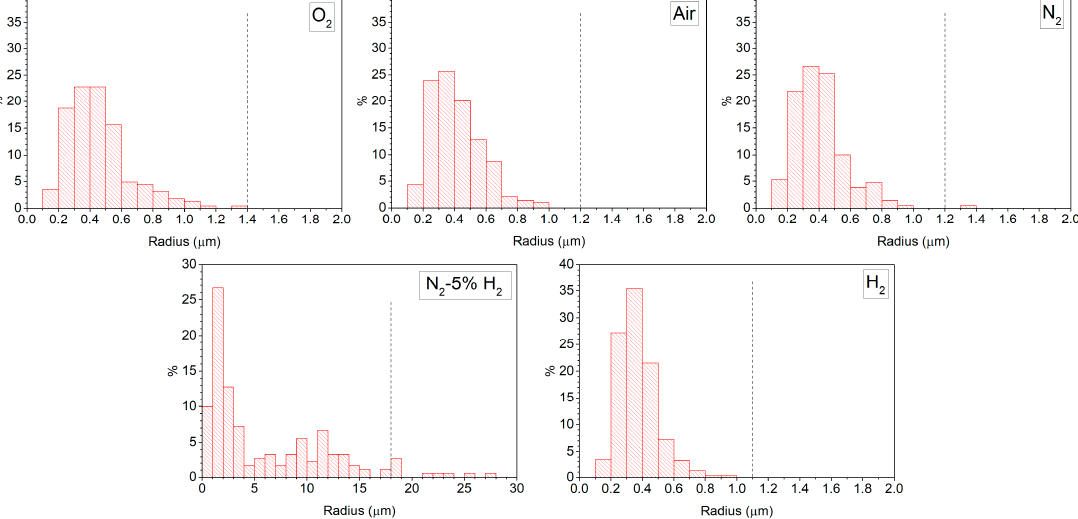
Figure 6. Grain size distributions of KNbO 3 samples sintered at 1040 °C for 1 h in different atmospheres.